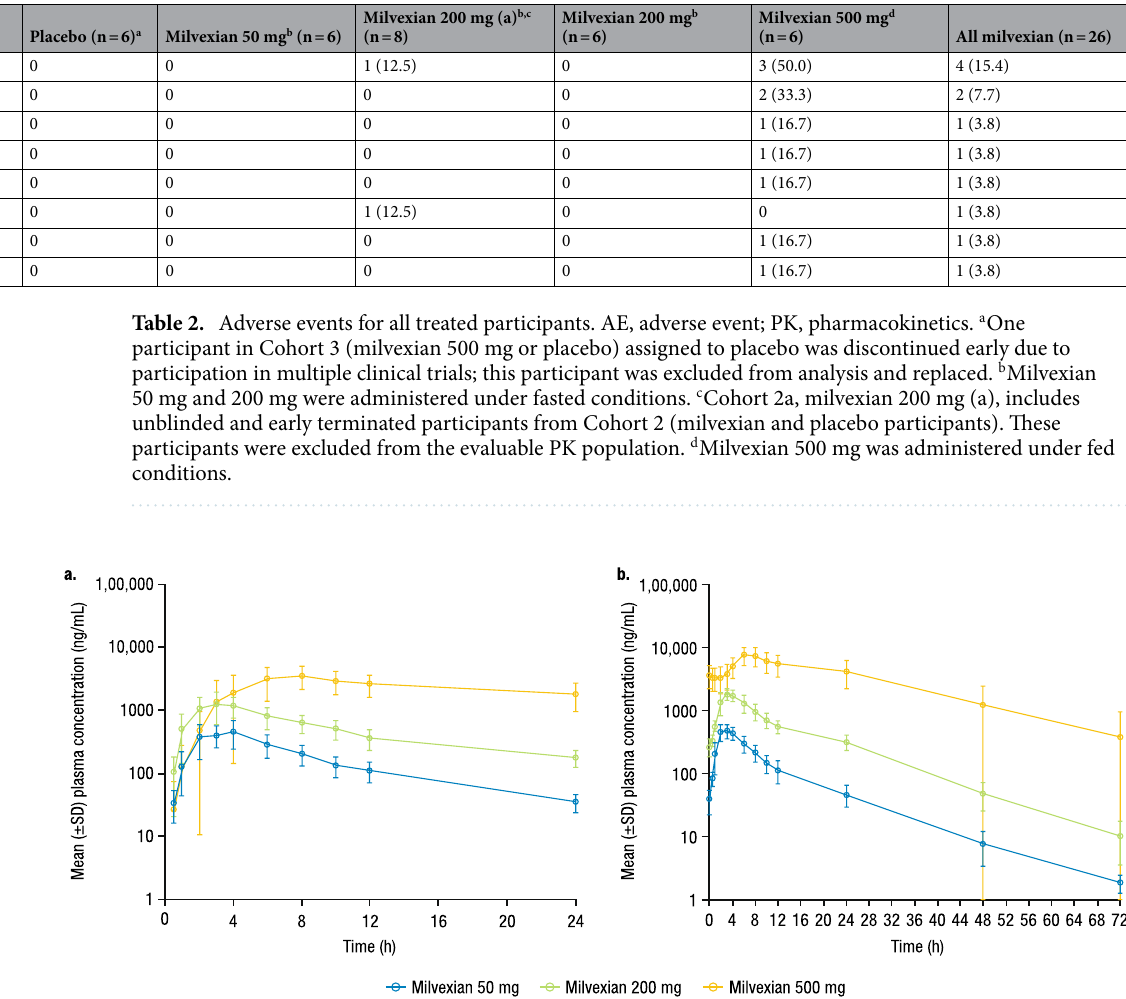
Figure 1. Mean (± SD) milvexian plasma concentration profile versus time by dose group on ( a ) Day 1 and ( b ) Day 14. SD, standard deviation. Milvexian 50 mg and 200 mg were administered under fasted conditions. Milvexian 500 mg was administered under fed